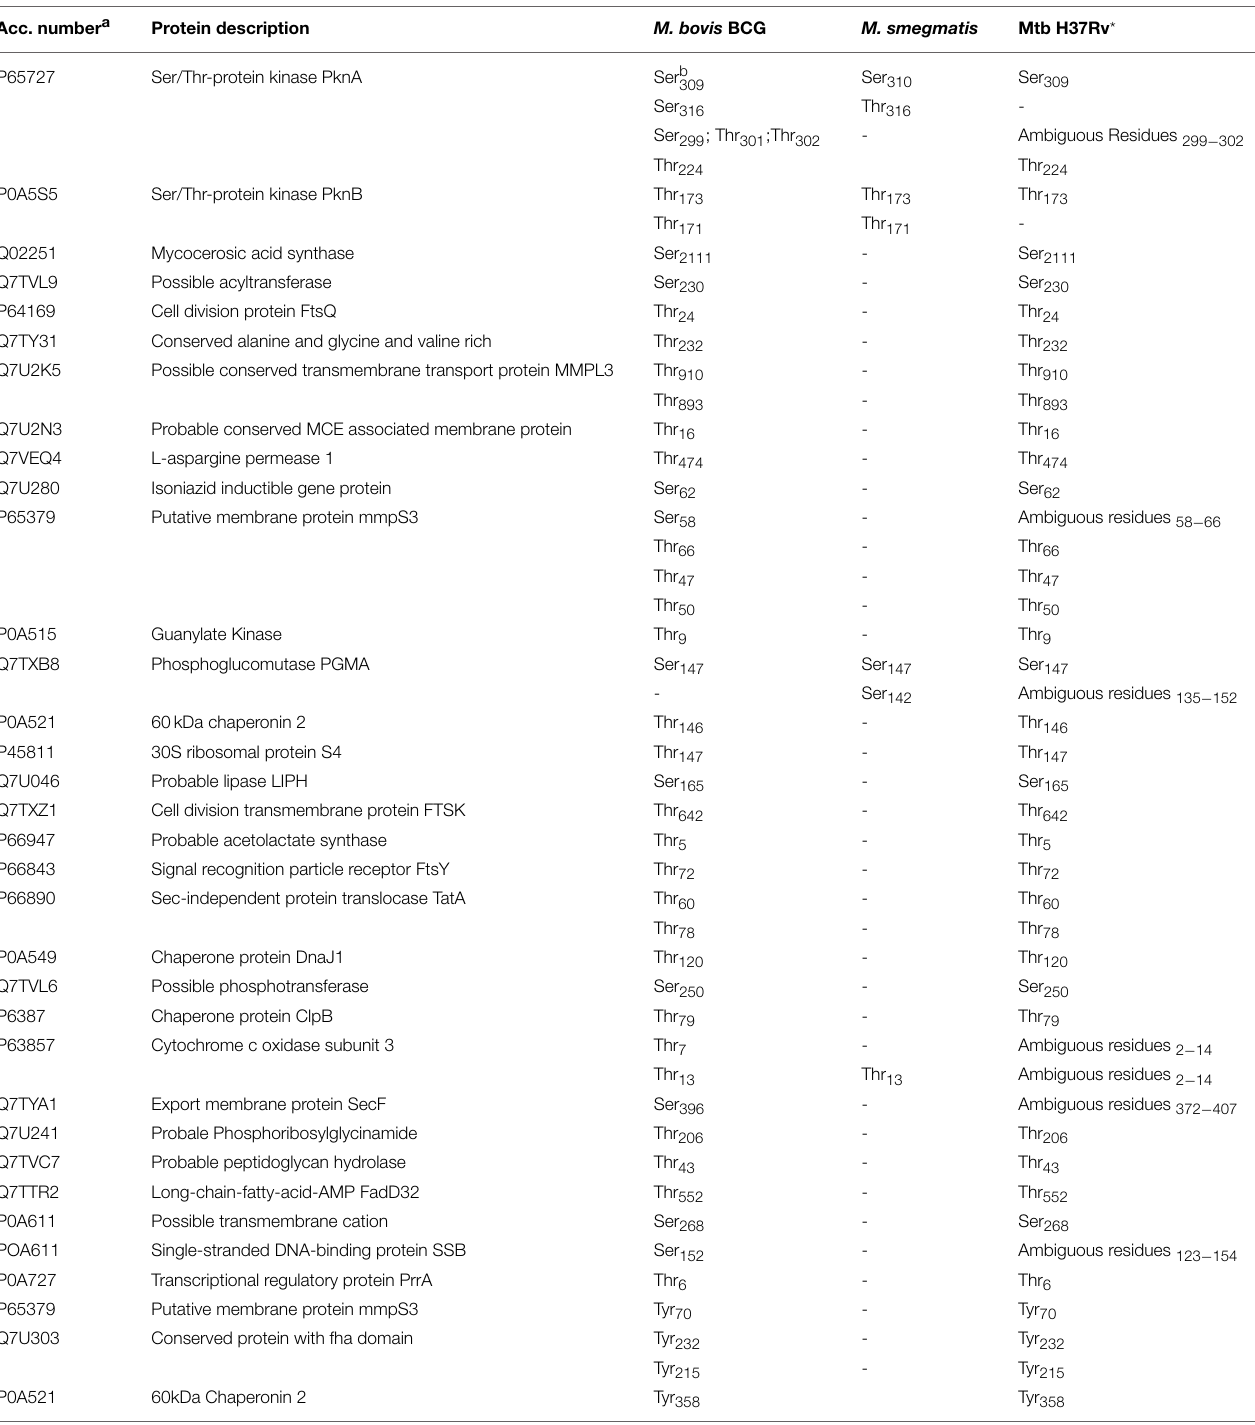
TABLE 2 | Summary of the phosphorylated sites found in more than one Mycobacterial species. Acc. number